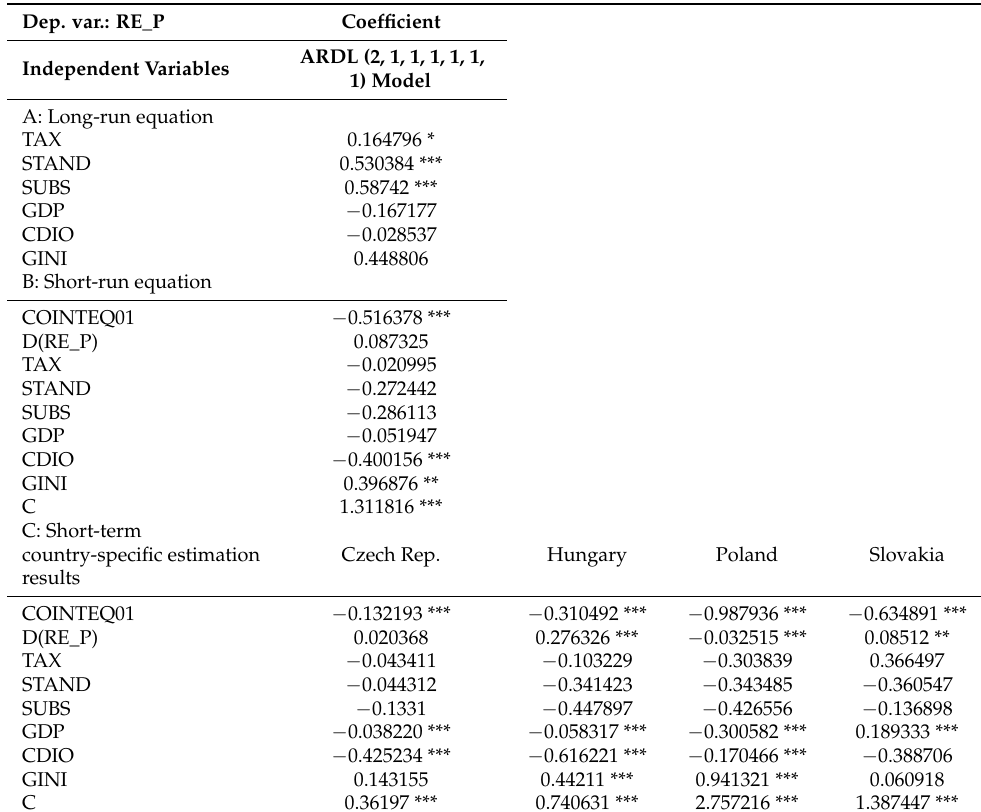
Table 18. Long-run and short-run coefficients for model